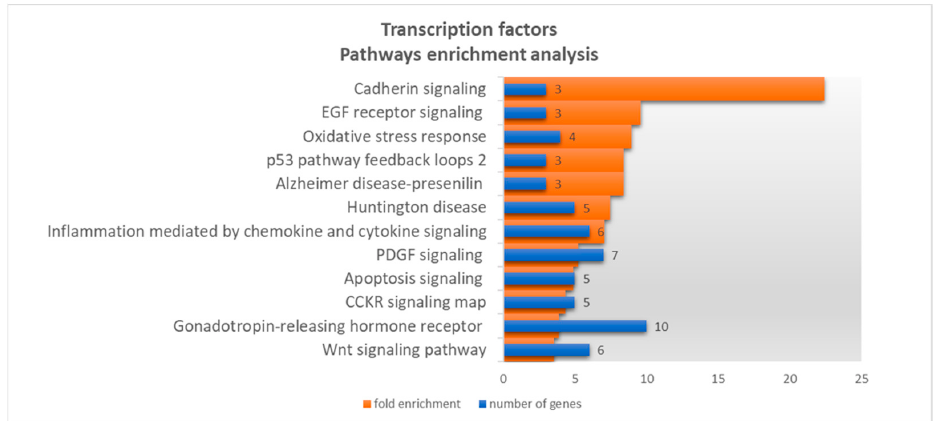
Figure 2. Gene ontology results for 80 potential NAPRT transcription factors, based on pathways annotation dataset, showing the number of genes (blue bars) and fold enrichment (orange bars) by decreasing fold enrichment order. Detailed information on GO results can be found in Supplementary Table S4. The genes responsible for the highest enrichment fold were retrieved (TCF7L2, TCF3 and